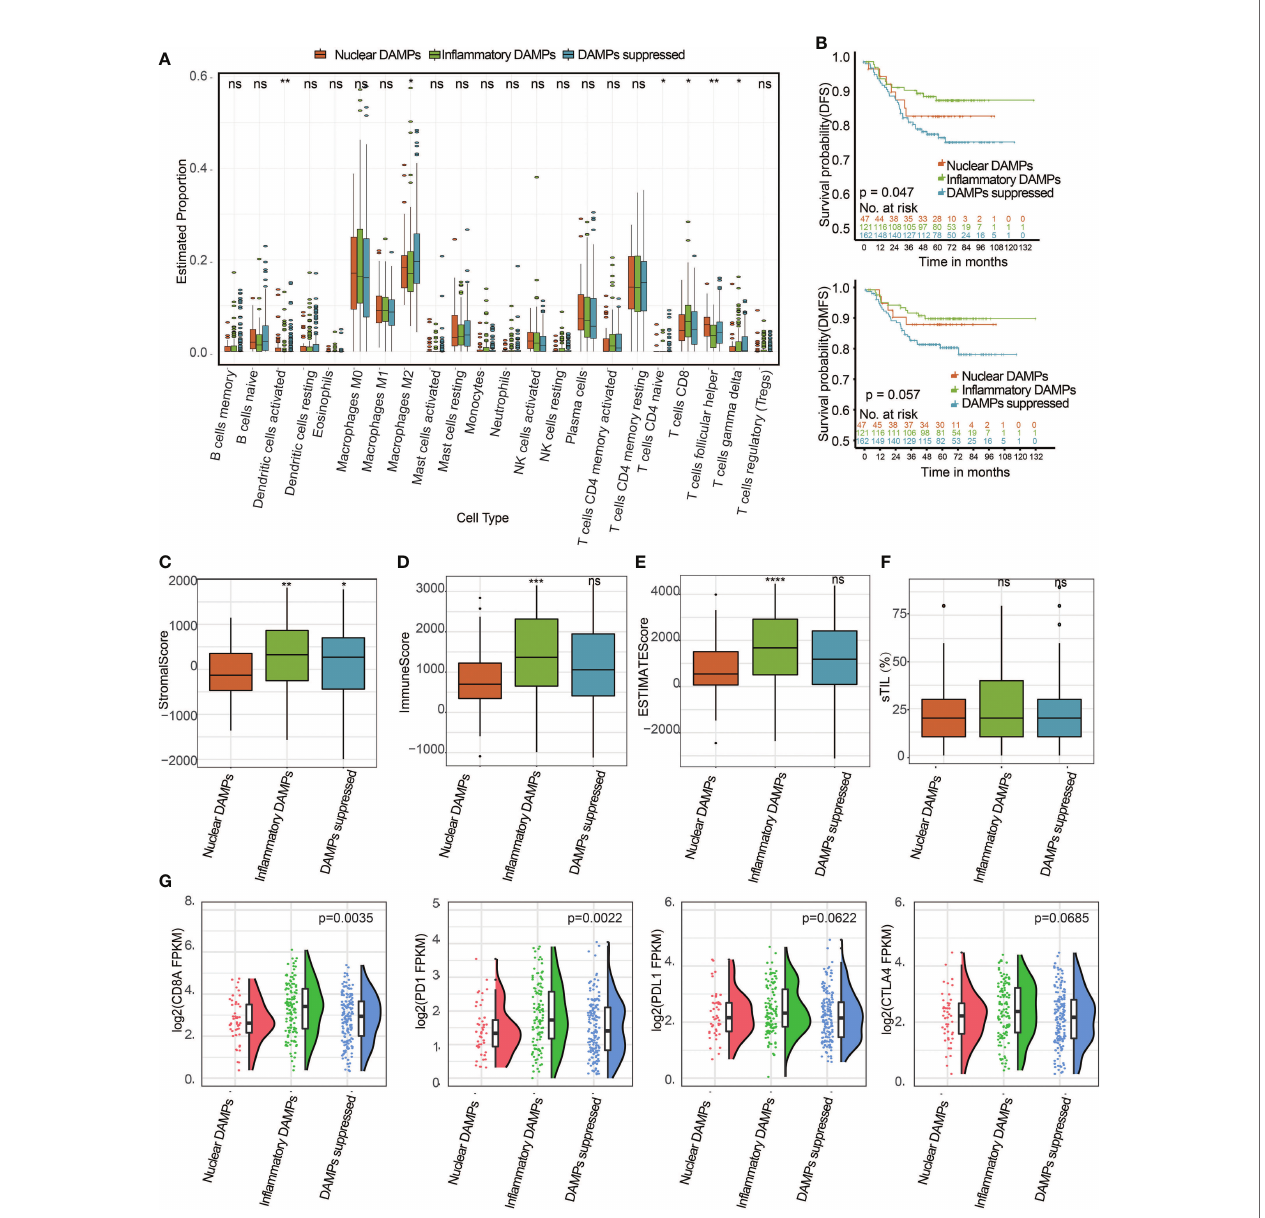
FIGURE 5 | Identi fi cation of DAMPs-associated subtypes among the FUSCC-TNBC cohort and comparison of their differences in tumor-in fi ltrating lymphocyte immune biomarker expression levels. (A) The differential estimated proportion of 22 CIBERSORT immune cell types in DAMPs-associated subtypes. The central line represents the median value. The bottom and top of the boxes are the 25th and 75th percentiles (interquartile range). The whiskers encompass 1.5 times the interquartile range. (B) Kaplan-Meier curves of disease-free survival (DFS) and distant metastasis-free survival (DMFS) among the three subtypes in the FUSCC cohort. (C) Stromal score in DAMPs-associated subtypes. (D) Immune score in DAMPs-associated subtypes. (E) ESTIMATE score difference among the three subtypes in the FUSCC cohort. (F) The sTIL difference among DAMPs-associated subtypes. (G) Expression differences in CD8A, PD-1, PD-L1 and CTLA4 among the three subtypes. *P < 0.05; **P < 0.01; ***P < 0.001; ****P < 0.0001; ns, not signi fi